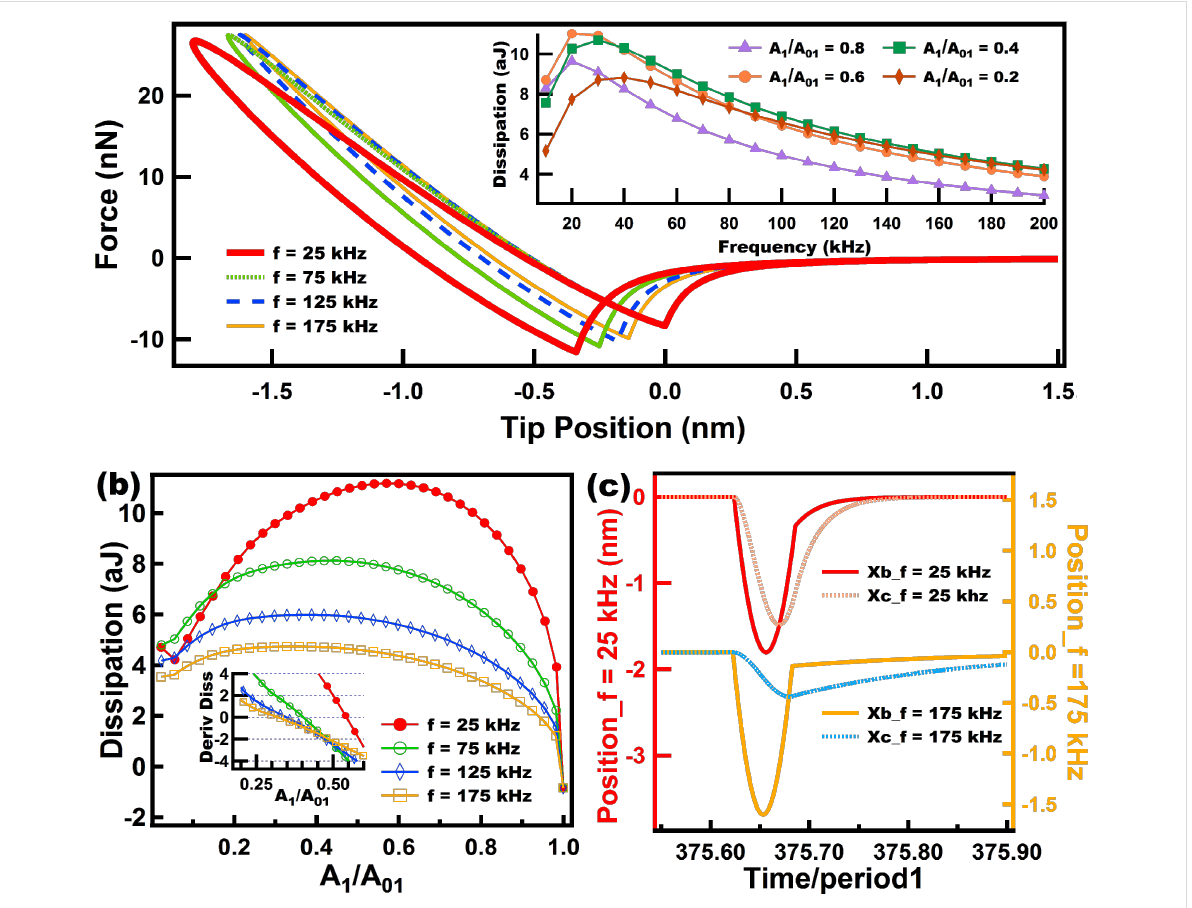
Figure 10: Results of energy dissipation when a realistic tip interacts in intermittent contact AFM with a standard nonlinear solid (SNLS). (a) Shows force–distance curves for tips driven at different eigenfrequencies (color coded). The inset in (a) shows the behavior of dissipation as frequency increases, and each color coded line relates to a specific amplitude setpoint ( A 1 / A 01 ). (b) Shows dissipation vs amplitude setpoint ( A 1 / A 01 ) curves where each color coded line corresponds to a specific eigenfrequency. The inset in (b) shows the slope of the curves in (b) plotted in the range where the slopes cross the x -axis in order to easily determine the maxima of the curves in (b). (c) Shows the response of the surface and dashpots of the SNLS model for two different cantilever eigenfrequencies. The parameters for the cantilever dynamics were the same as in Figures 6 to 9. The sample parameters were the same as for Figure